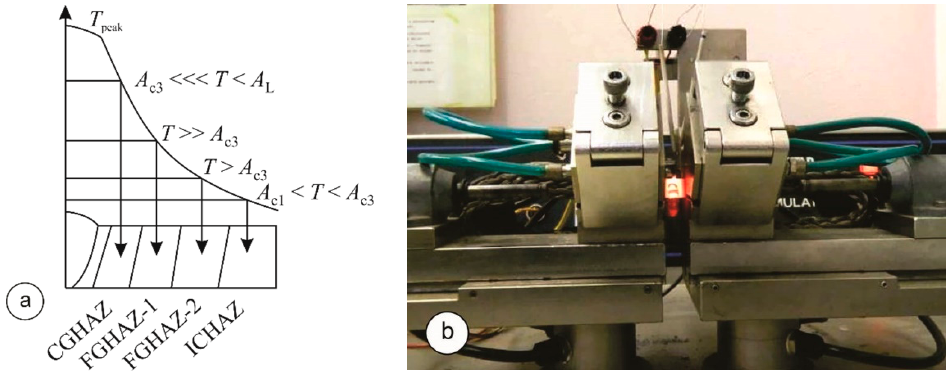
Figure 1. ( a ) HAZ subzones of interest; ( b ) A specimen during simulation-SMITWELD 1405.